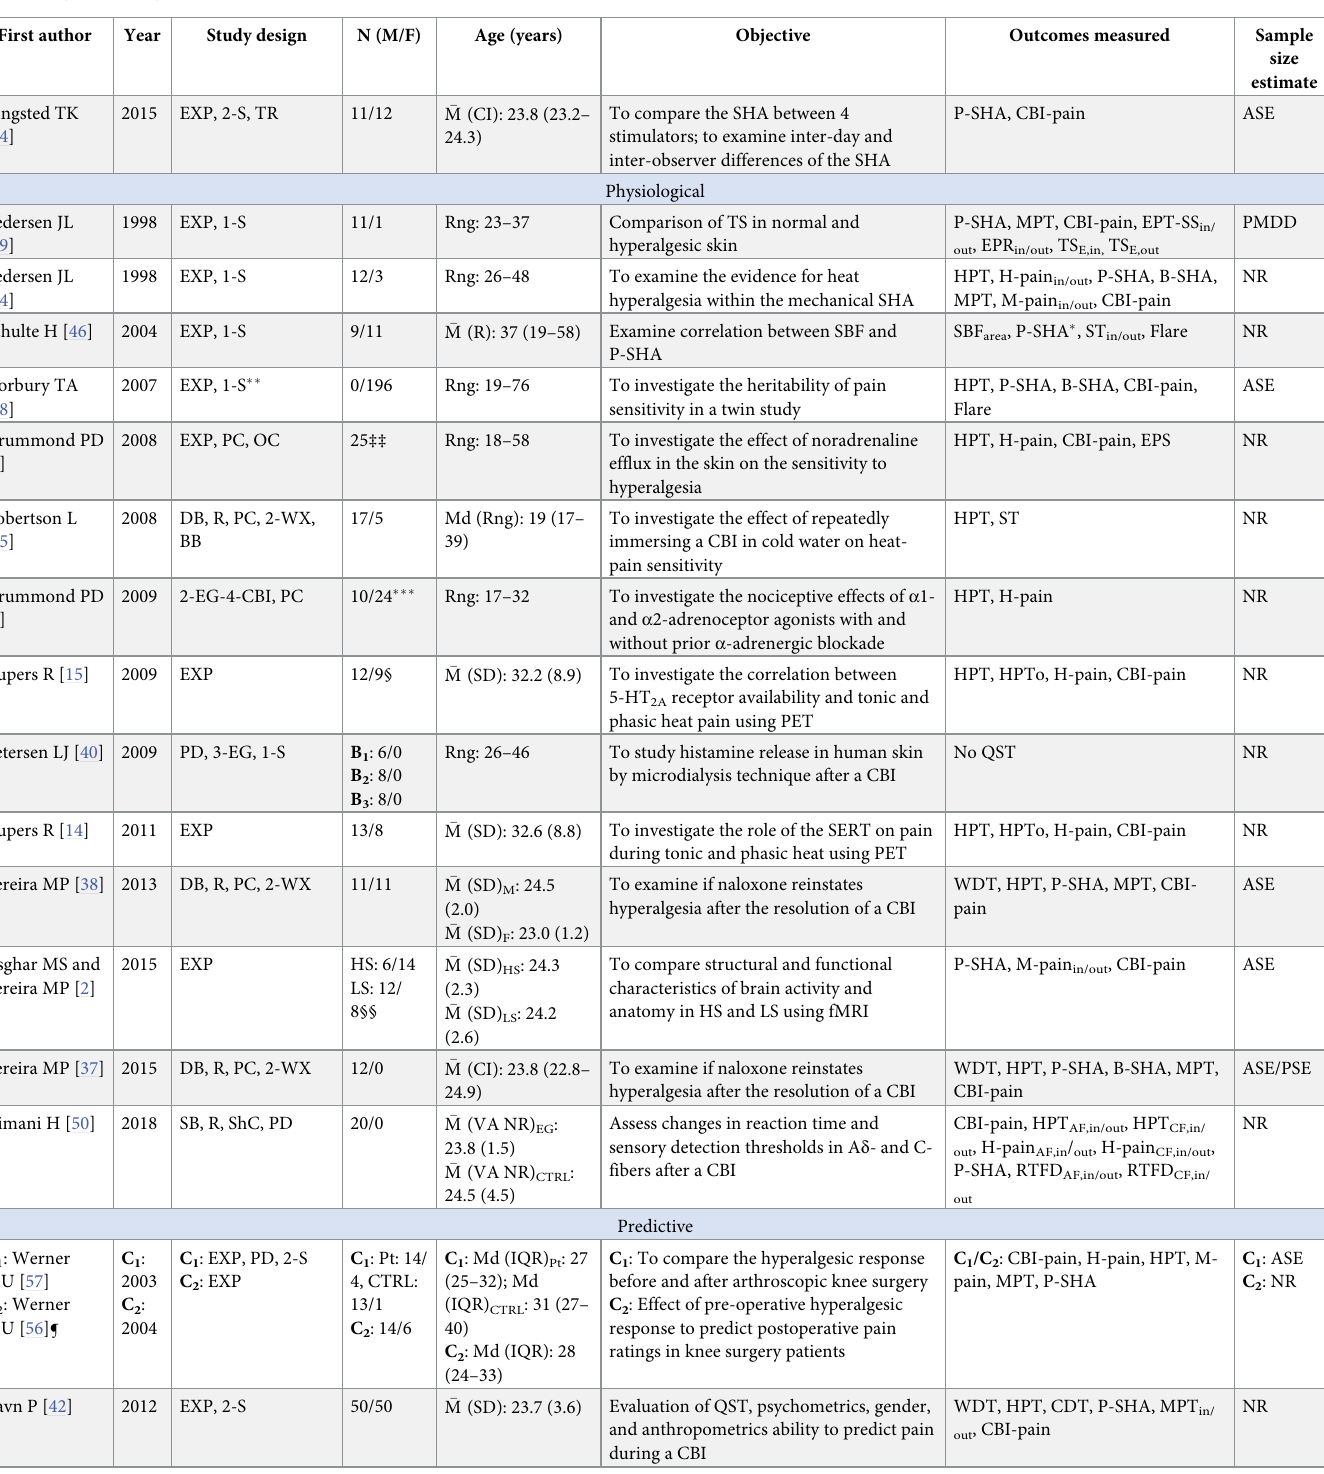
C 1 : To compare the hyperalgesic response before and after arthroscopic knee surgery C 2 : Effect of pre-operative hyperalgesic response to predict postoperative pain ratings in knee surgery